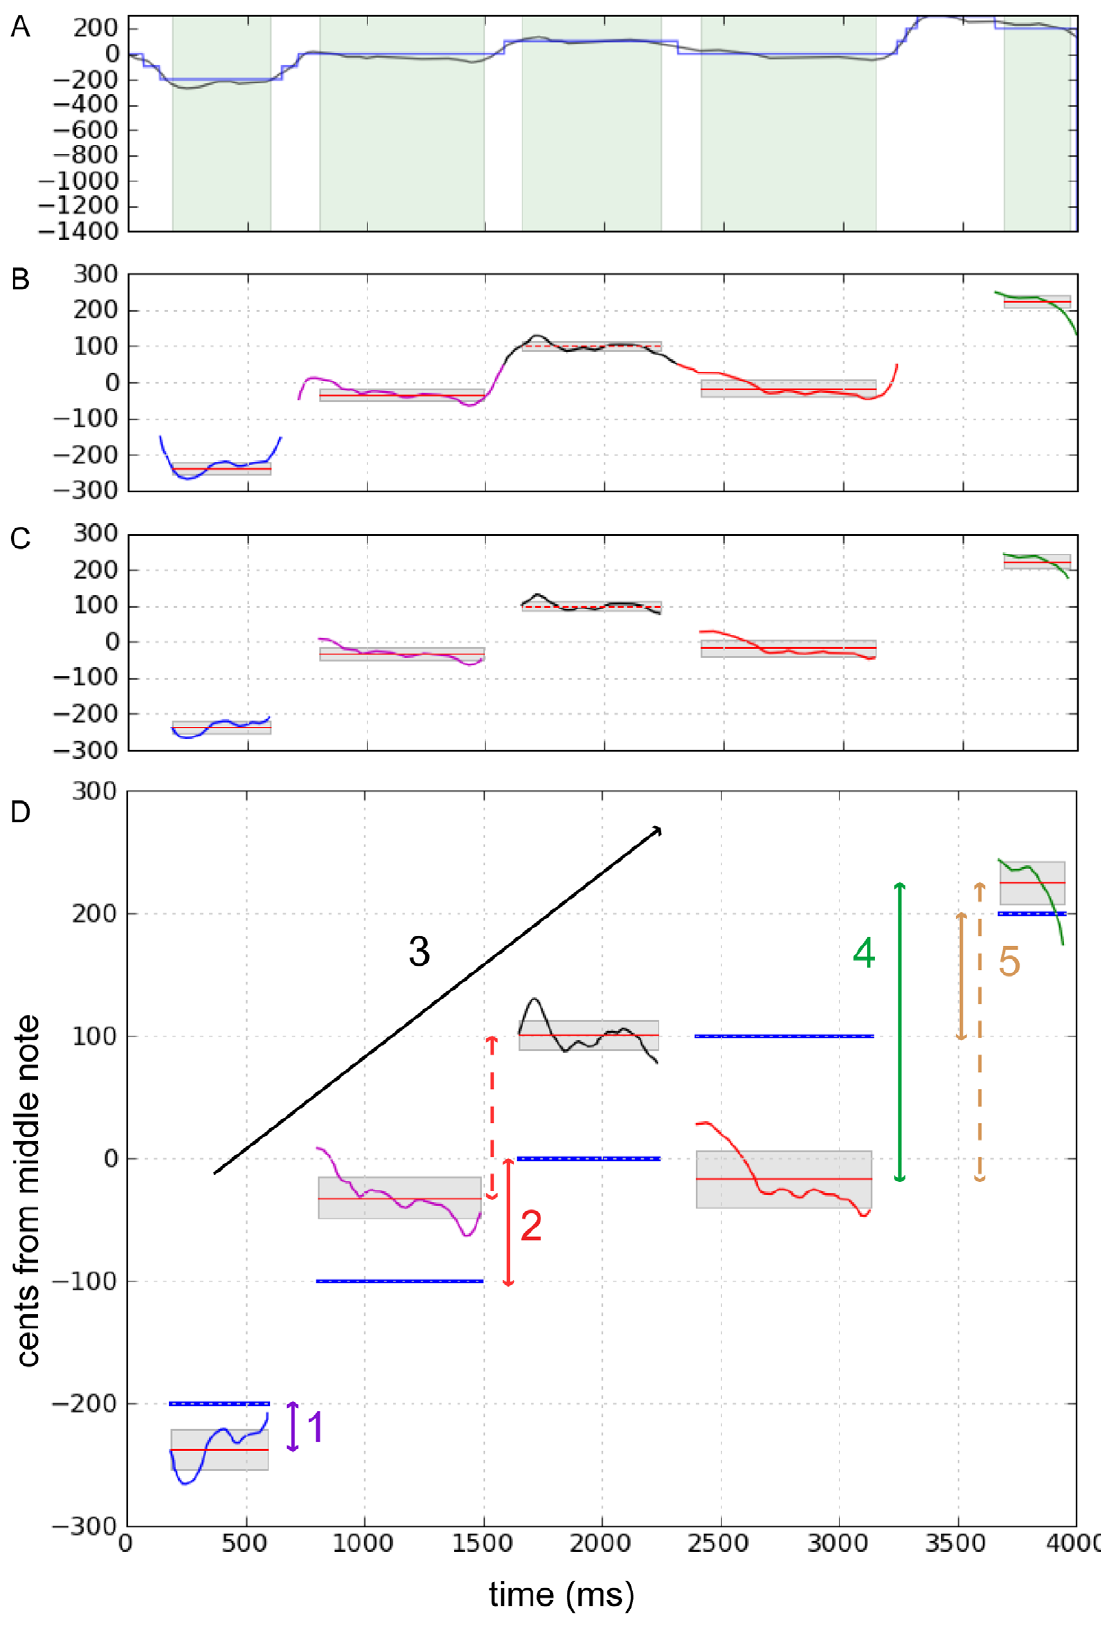
Figure 6. Segmentation and performance measures applied to sung melodies. For all plots, the x-axis represents time in milliseconds, and the y-axis represents vocal pitch converted to cents, relative to the middle note (252 Hz). A: The raw pitch trace (black line) of a non-musician’s sung